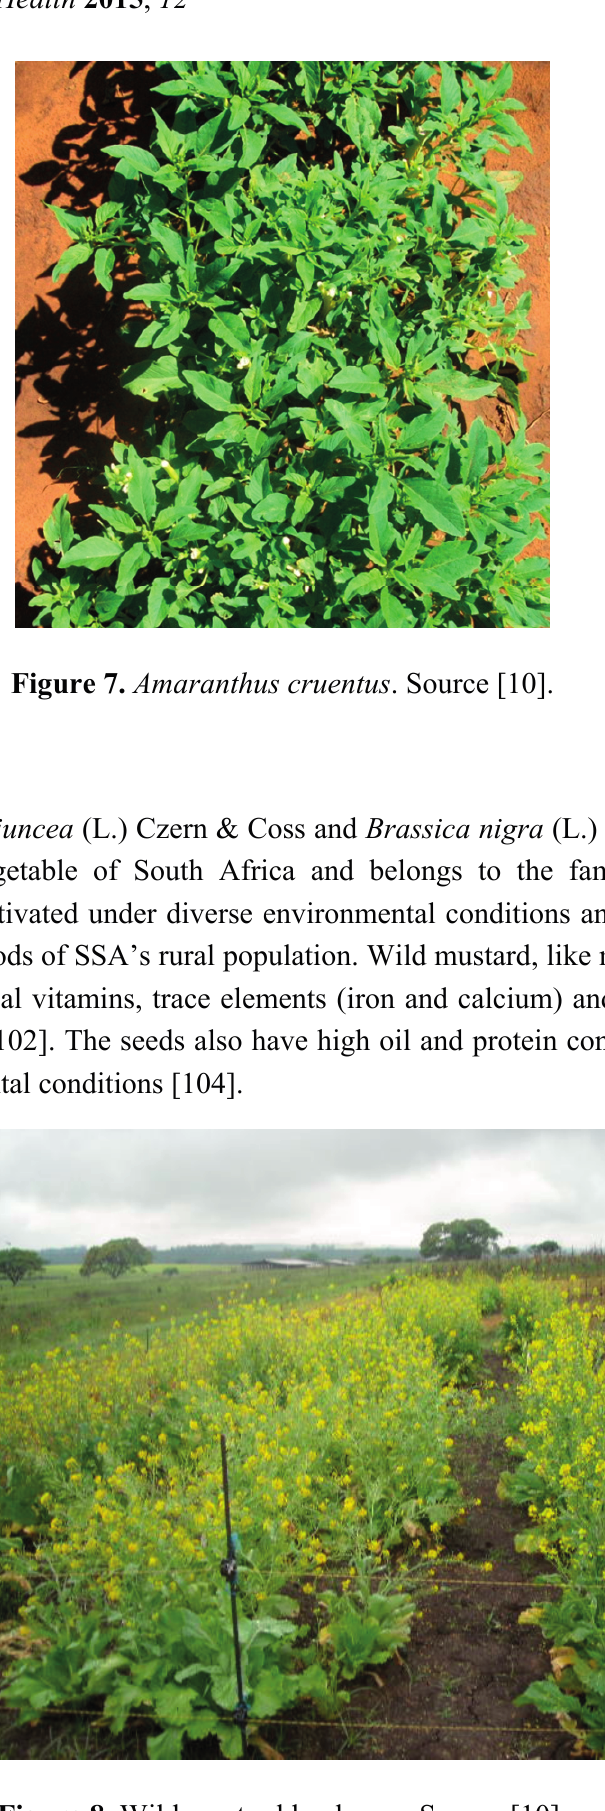
Figure 8. Wild mustard landraces. Source